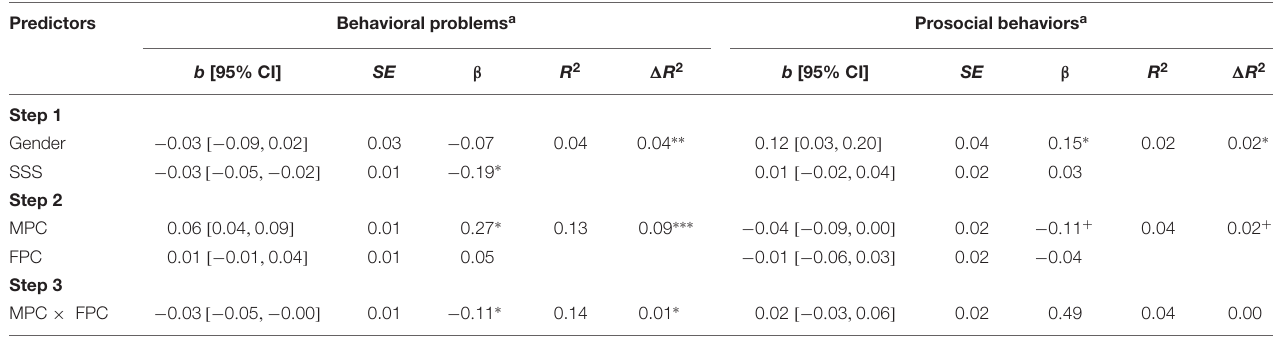
TABLE 4 | Regression analysis for parental psychological control predicting children’s socioemotional outcomes. Predictors